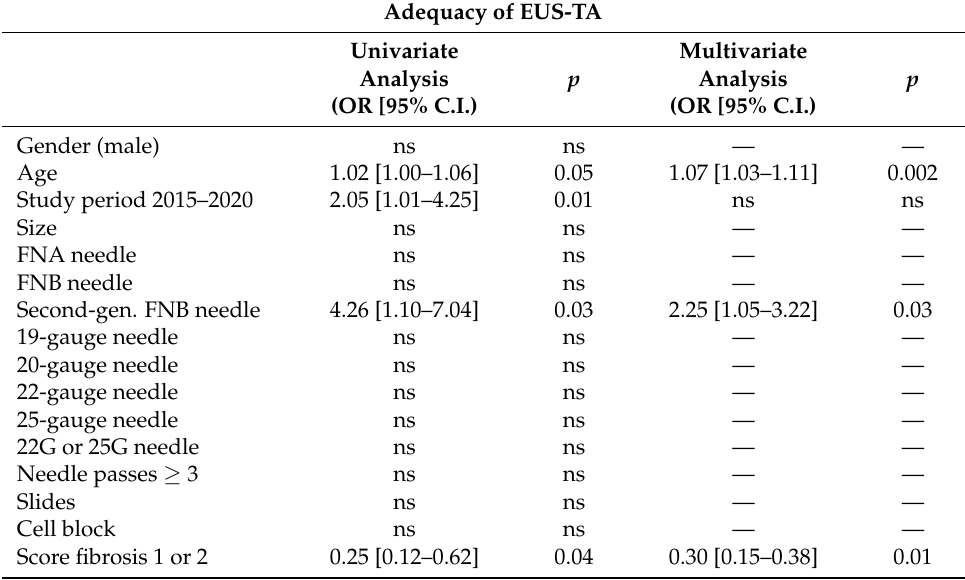
Table 4. Variables related to EUS-guided tissue acquisition specimen adequacy for solid pancreatic tumors located in the head/uncinate process.